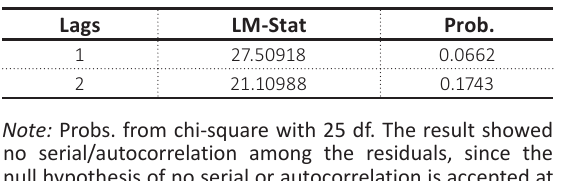
Table 6. VAR residual serial correlation LM tests